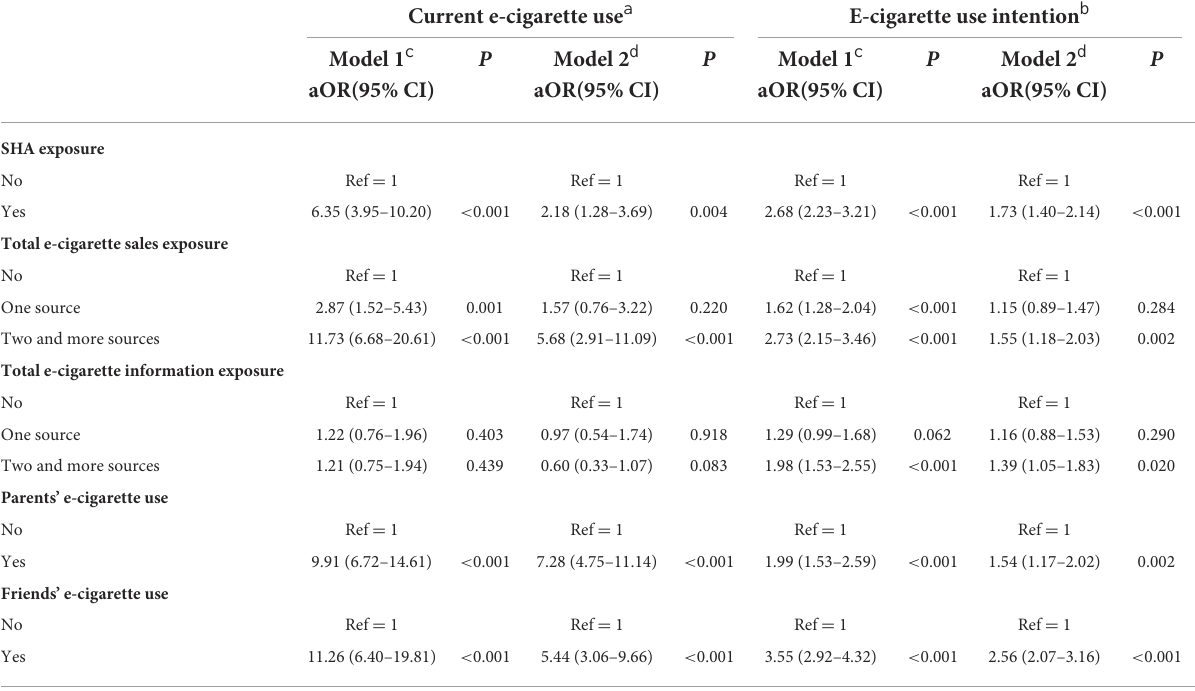
TABLE 3 Association between social-environmental e-cigarette exposure and adolescents’ e- cigarette use and